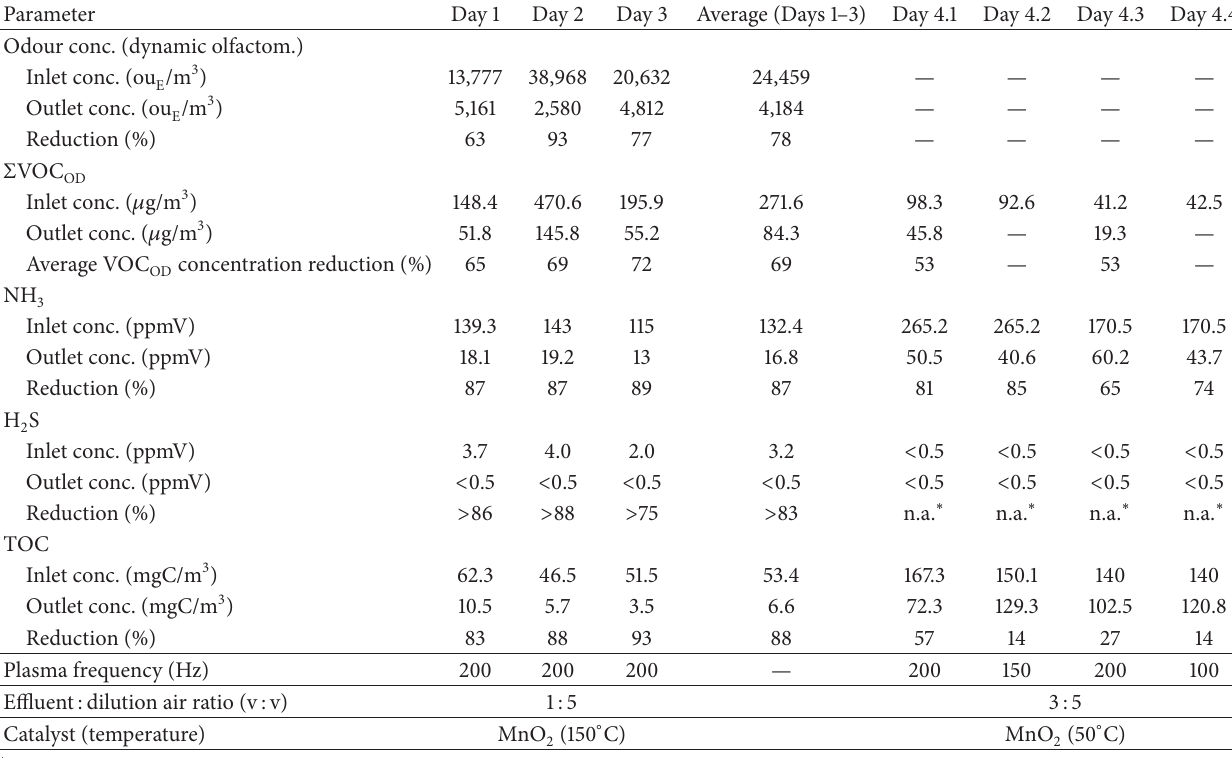
, NH , H S, and TOC concentrations, and % reduction in each OD 3 2